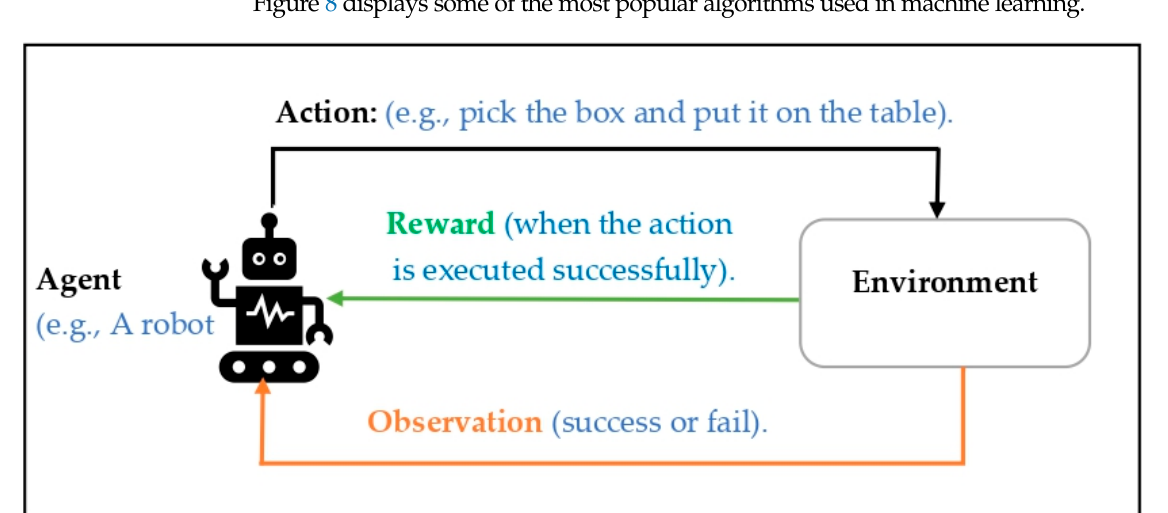
Figure 7. Reinforcement learning model.